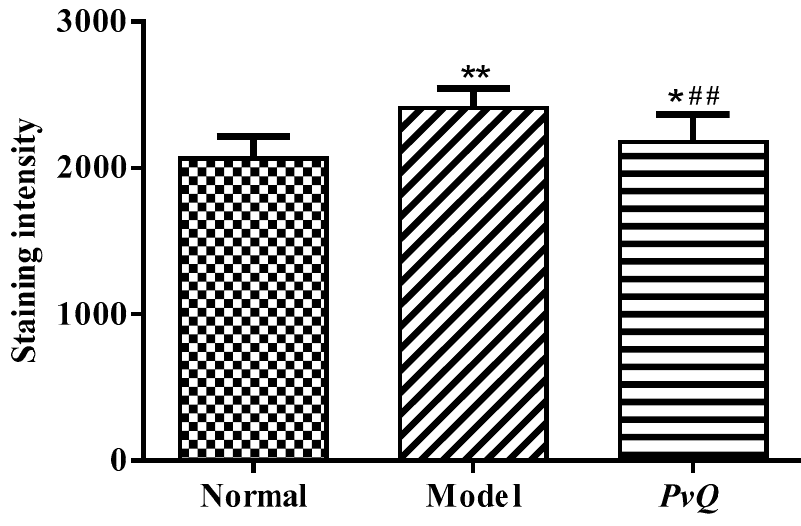
Figure 4. The staining intensity of tail vein erythrocytes. Data are expressed as mean ± SD (n = 18). * p ≤ 0.05, ** p ≤ 0.01 compared to the normal group; ## p ≤ 0.01 compared to the model group.